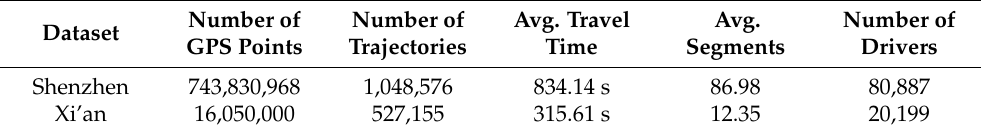
Table 2. Statistics of trajectories of two